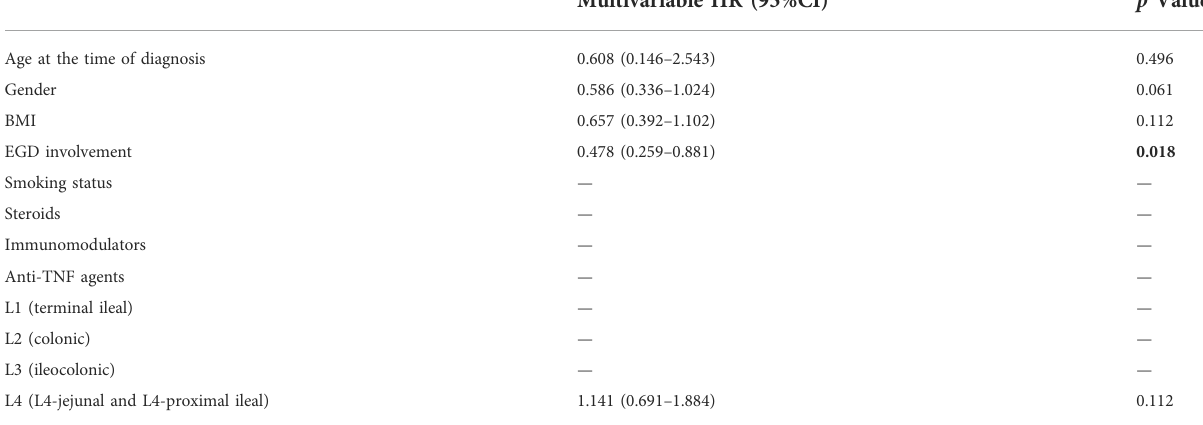
TABLE 4 Analysis of possible risk factors predicting intestinal fi stula using the Cox Model ( N =